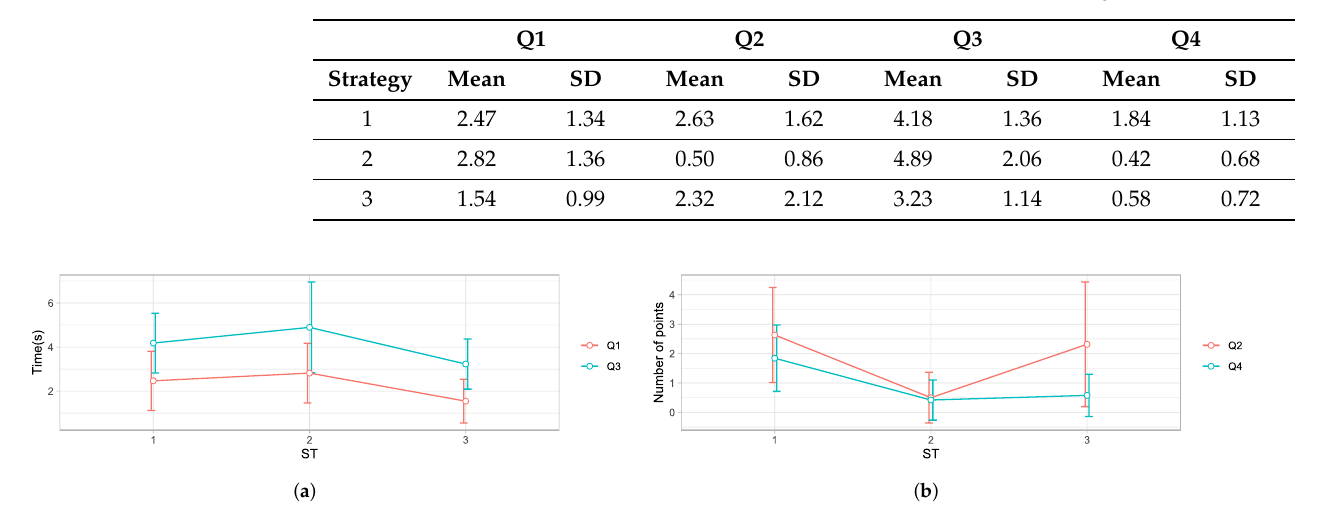
Table 2. Mean and standard deviation of Q1, Q2, Q3, and Q4 for different strategies.